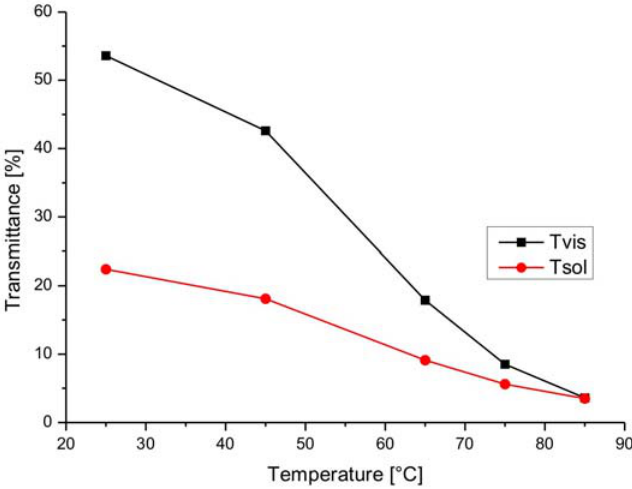
Figure 5. Temperature dependent transmittance behavior of a LETC system (Tvis = Total light transmittance in the visible range 380–770 nm, Tsol = Total solar transmittance range 300–2,500 nm; data from